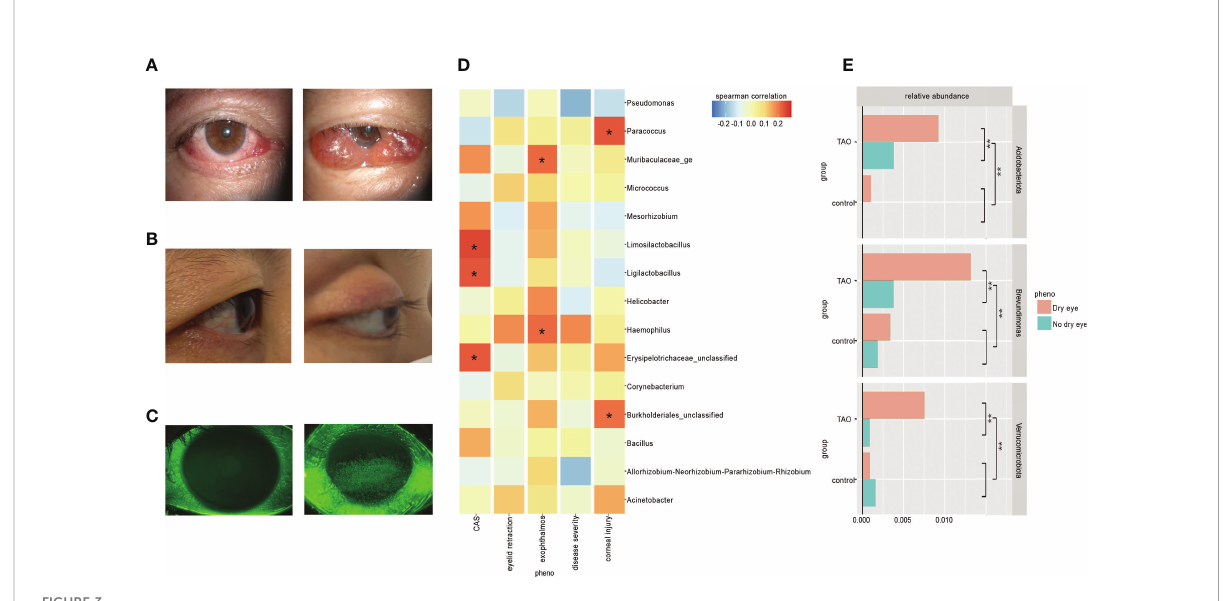
FIGURE 3 (A) Ocular surface symptoms of different disease activity in the thyroid-associated ophthalmopathy (TAO) patients. (B) A healthy people (left) and a TAO patient with exophthalmos (right). (C) Corneal fl uorescein staining results of a healthy person (left) and a TAO patient with moderate corneal epithelial injury (right). (D) Bacteria with higher Spearman ’ s correlation coef fi cients with CAS, eyelid retraction, exophthalmos, disease severity, and corneal injury in TAO patients are shown at the genus level. (E) There were signi fi cant differences in the average relative abundance of some bacteria within TAO group and between groups according to dry eyes (t-test dichotomous traits and t-test regression coef fi cients,